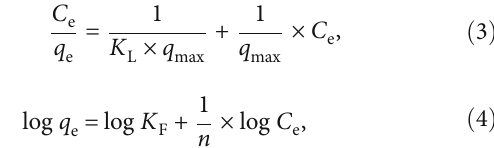
Scheme 1: The process of fabricating a new adsorbent by coating graphene oxide/Fe fabric (NWPF) extracted from discarded disposable face